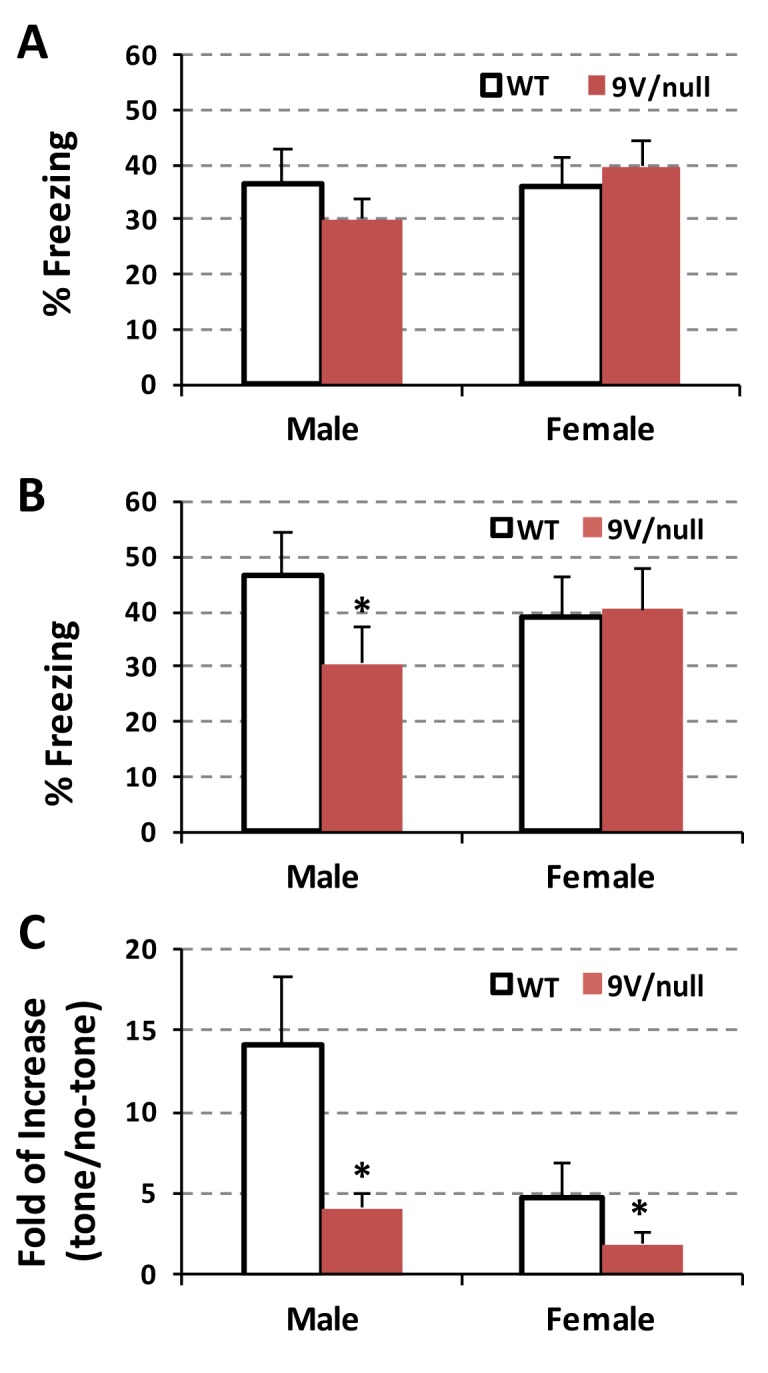
Hippocampus-related memory defects in 9V/null mice evaluated by conditional fear test.A: The mice at 12 months of age were trained to tone-shock pairings on Day 1 in the test chamber for 6 min and percentage of freezing time were quantified. B: On Day 2 (contextual) they were tested for freezing in the same environment without tone and data was presented as percentage of freezing events. C: On Day 3 (cued), a dark acrylic triangular box was placed within the test chamber. After habituation without tone, mice were exposed to the tone. Freezing events were measured and presented as fold of changes with the tone verse without the tone. 9V/null mice exhibited a significant decrease in response to contextual fear in male and auditory-cued fear in both genders compared to age- and gender-matched WT at 12 months of age. *, p<0.05 (n  =  11–12 mice per group) by two-way ANOVA.